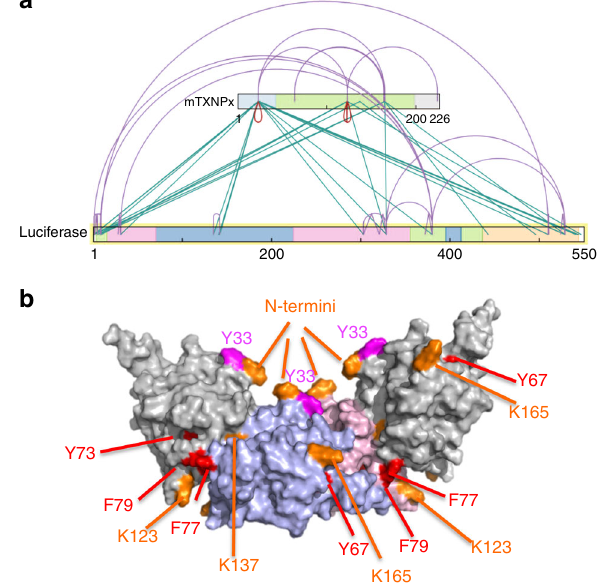
Fig. 5 In vitro cross-linking of mTXNPx red -luciferase complexes. a Intra - protein (purple lines) and inter- protein (cyan lines) cross-link maps using xiNET (Supplementary Data 1). The mTXNPx sequence including the mitochondrial targeting sequence was used for the map. b Mapping of the in vitro cross-linking sites between mTXNPx red and luciferase (shown in orange) and the in vivo cross-linking sites between mTXNPx-Bpa variants and cellular client proteins (red: Group 1 cross-links; pink: Group 2 cross- links, Fig. 4a) onto the quaternary structure of L. infantum TXNPx red . For simplicity, only one of the fi ve dimers that are present in the decamer (subunit A in pink and subunit B in blue) as well as one adjacent subunit on each side (grey) are